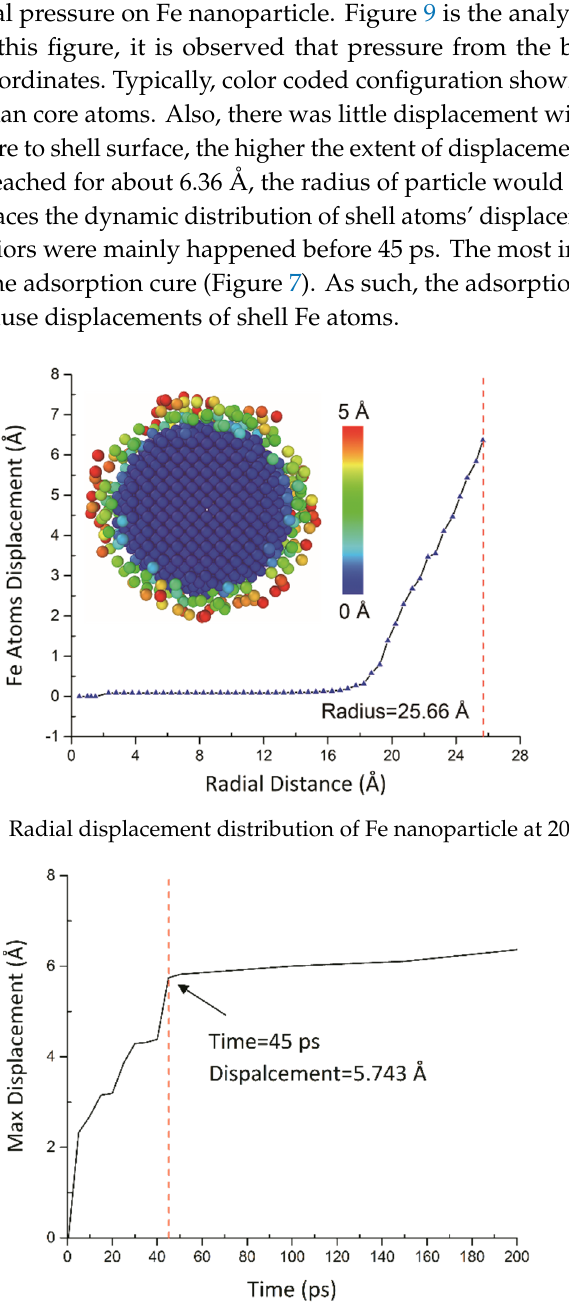
Figure 10. Plot of maximum displacements of Fe nanoparticle as a function of time.